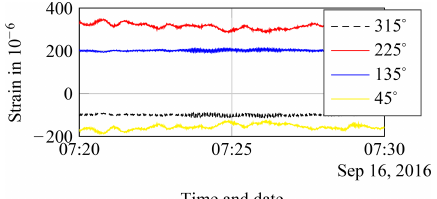
Figure 6. Example strain data. A wind direction of approximately 235 ◦ leads to wind-induced oscillations for the sensors at 225 ◦ (ten- sion) and 45 ◦ (compression) and oscillations in its eigenfrequencies in side-to-side direction (sensors at 135 and 315 ◦